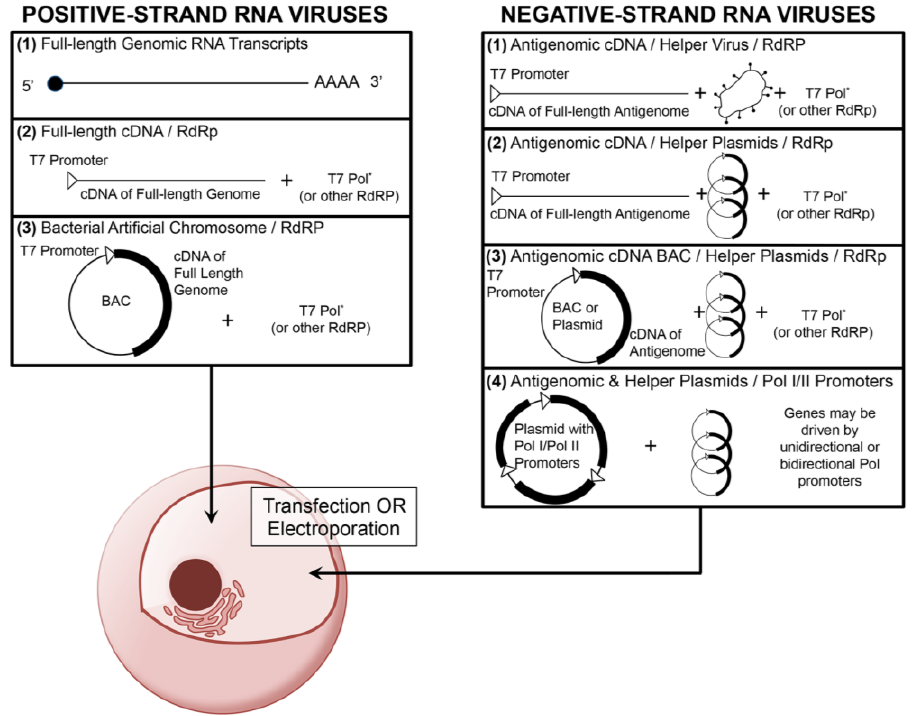
Figure 1. An overview of common reverse genetic platforms for the recovery of positive- and negative-strand RNA viruses. Most positive-strand RNA virus reverse genetic platforms consist of either direct introduction of full-length copies of the viral genome (which have been transcribed in vitro ) or introduction of either a linear or plasmid-associated (bacterial artificial chromosome, BAC) cDNA of the full-length genome in combination with an RdRp (such as T7 polymerase). Negative-strand RNA virus reverse genetic platforms often involve transfection or electroporation of genomic or more commonly subgenomic cDNA into permissive cells in combination with either a helper virus or helper plasmids, all of which driven by a RdRp. Some negative-strand RNA systems employ host polymerase I (Pol I) and II (Pol II) promoters to drive viral RNA synthesis and mRNA production. In both positive- and negative-strand reverse genetics systems, the RdRp (*) is typically constitutively or transiently expressed in the permissive cell